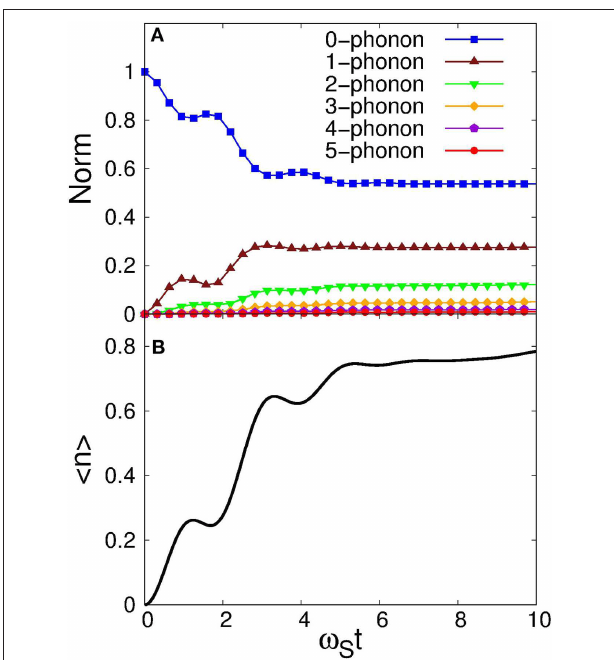
K k = 1 ˜ n k . The solid = P